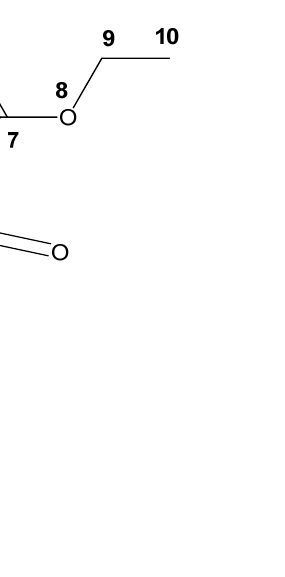
Table 2. 13 C Chemical shifts of 5a in CDCl 3 (100 MHz).